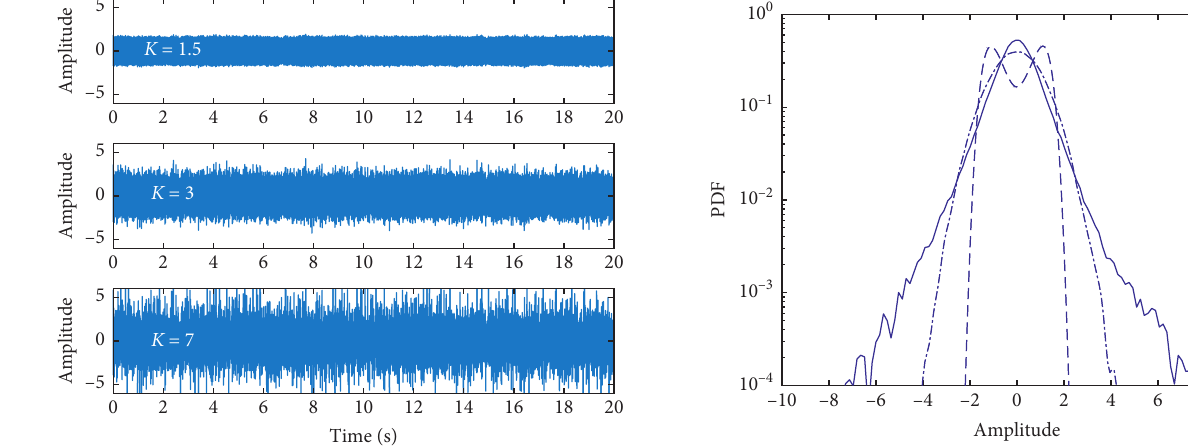
Figure 1: Three random time histories with different